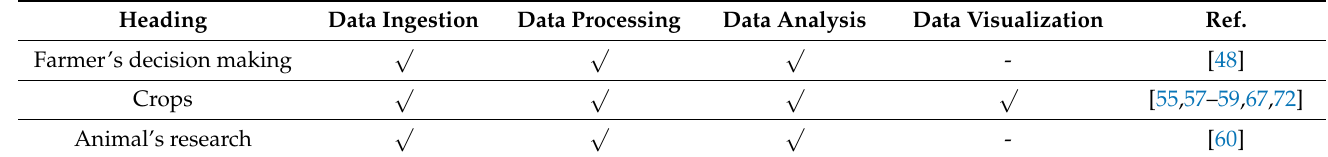
Table 12. Layers of ML Big Data architectures used in agriculture.